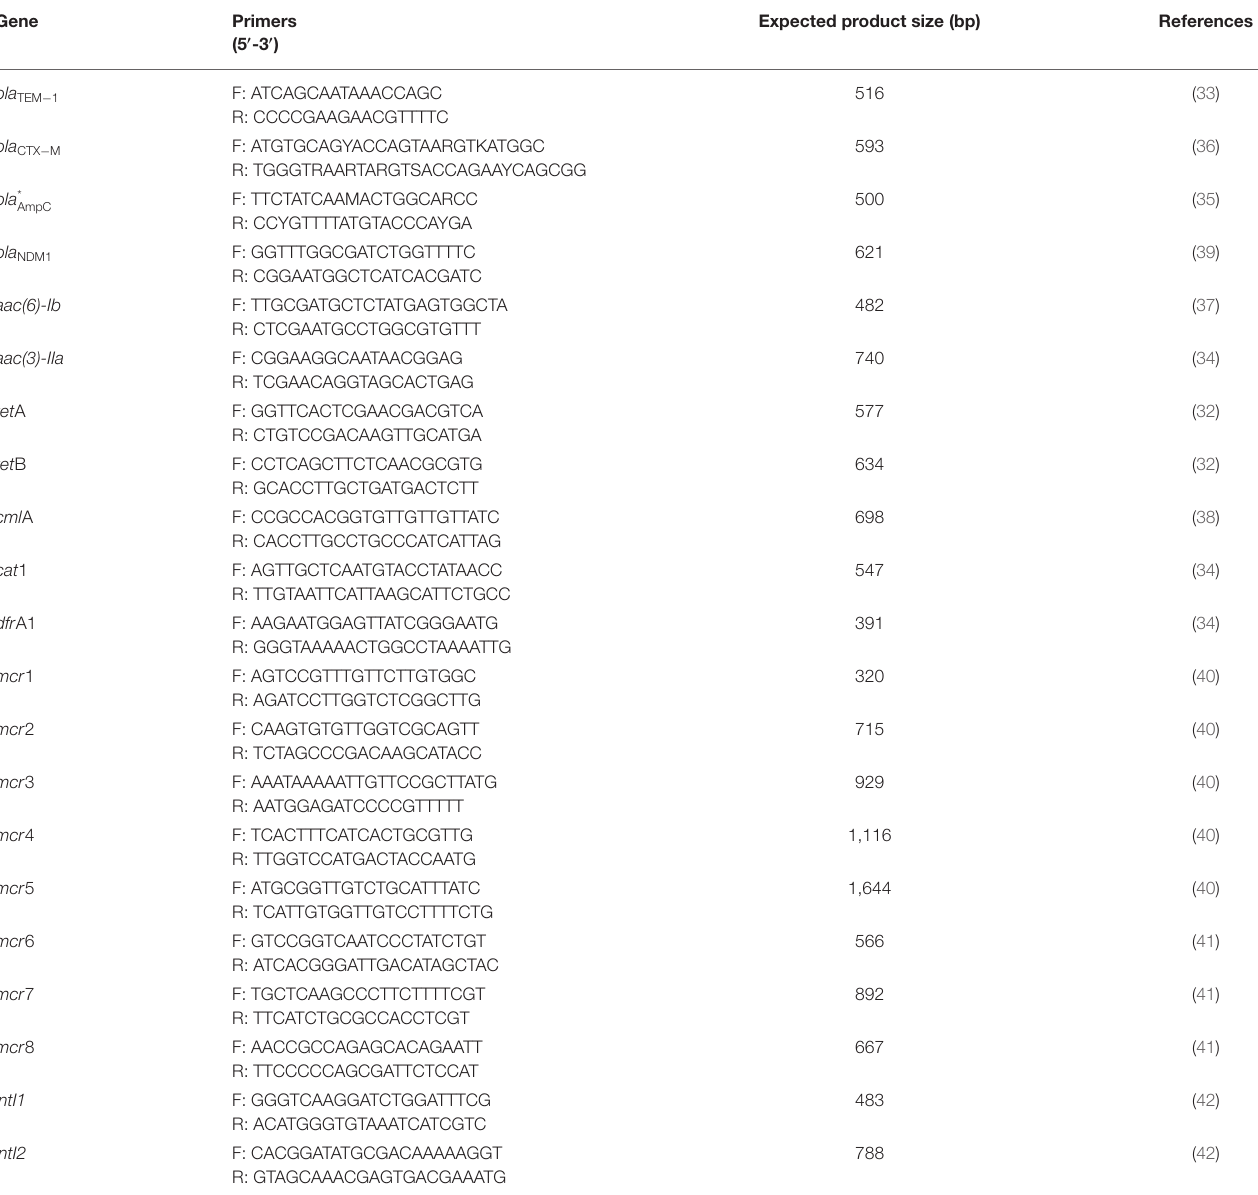
Expected product size